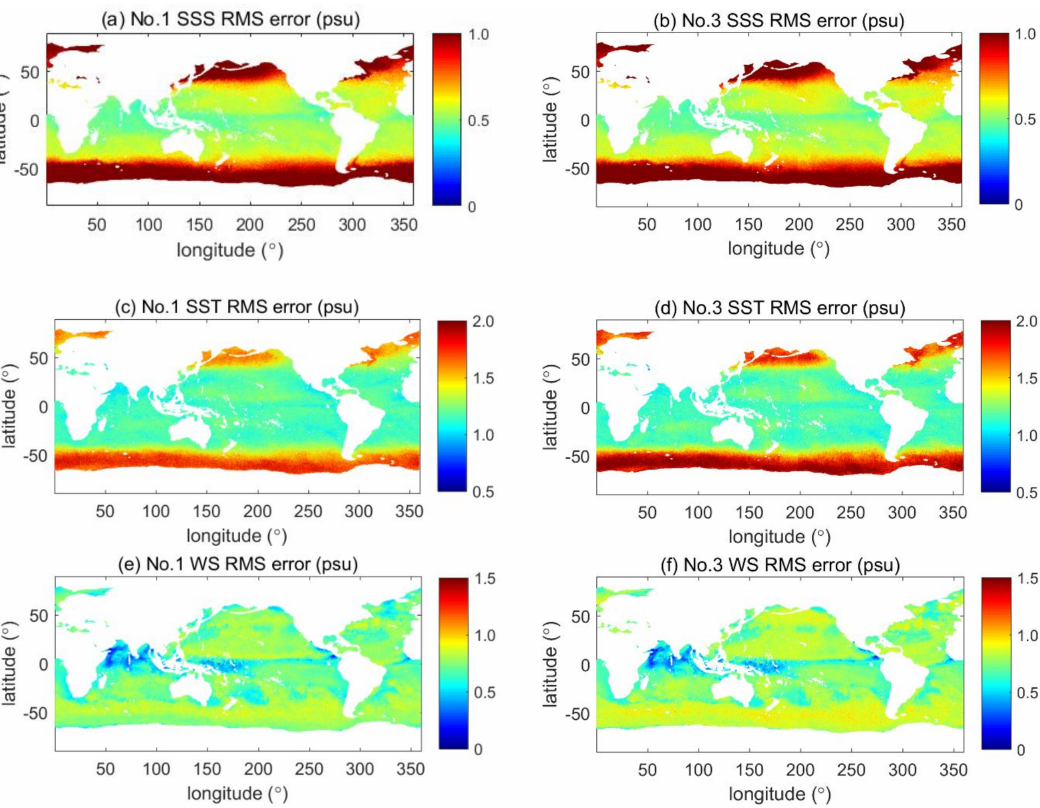
Figure 4. The errors on the retrieved SSS, SST, and WS with default configuration and with default configuration except 23.8 GHz of MICAP during only one satellite pass: SSS ( a ); SST ( c ); and WS ( e ) errors with No. 1 configuration; and SSS ( b ); SST ( d ); and WS ( f ) errors with No. 3